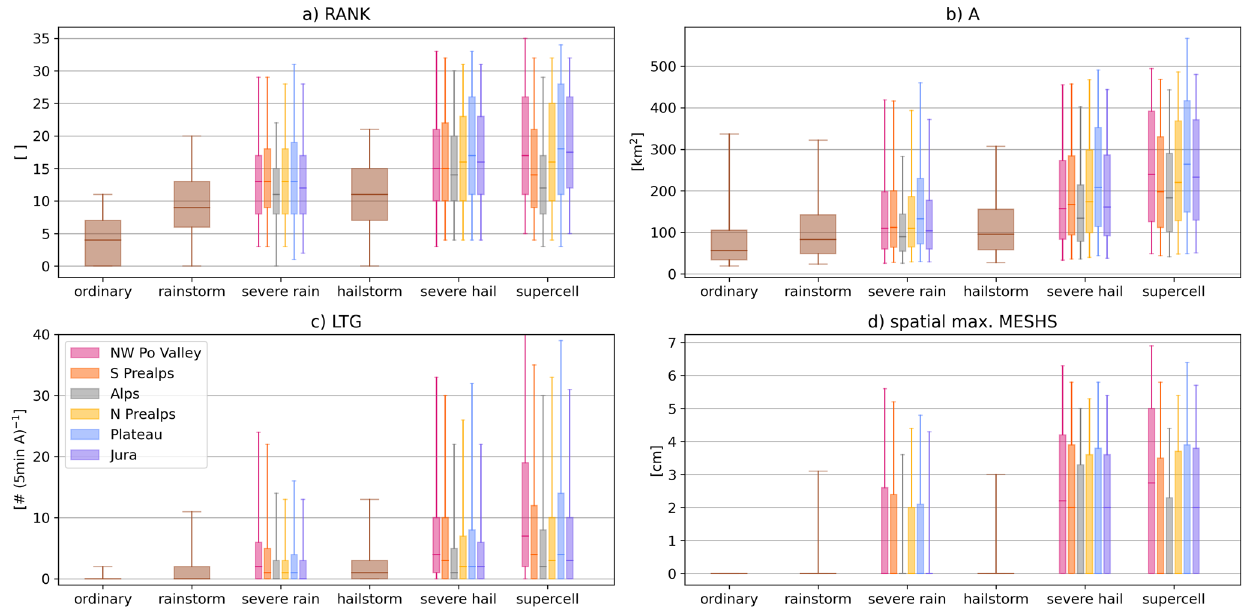
Fig. 6 Distribution of four variables for the different thunderstorm types in each topographic region. a Severity rank, b storm area, c lightning strikes, d maximum MESHS. The boxplots depict the median (centre line), 25th and 75th percentiles (bounds of box) and 5th and 95th percentiles